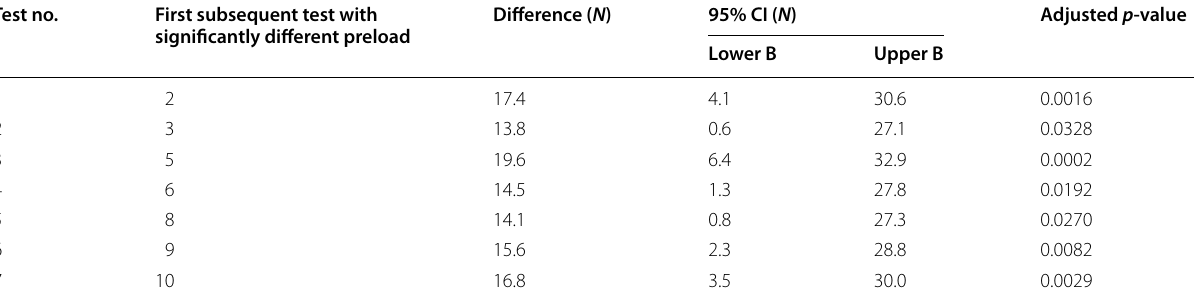
Table 1 First test following any test with significantly different preload Test